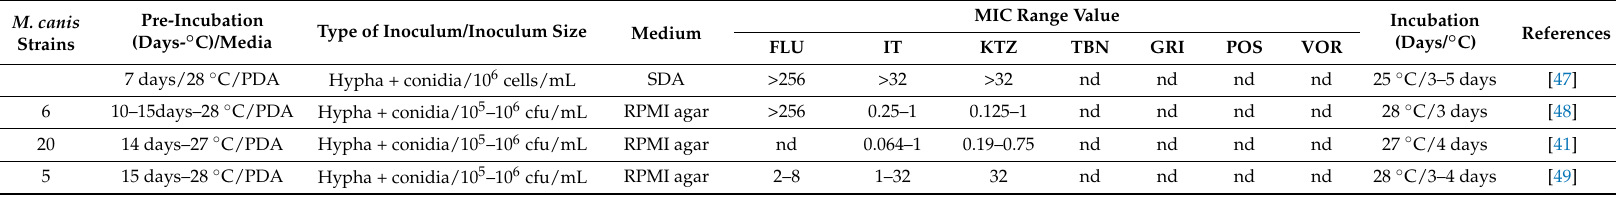
Table 3. E-test procedures for antifungal susceptibility in Microsporum canis . Range of MIC values ( µ g/mL) of azoles, grisefulvin, and terbinafine were also